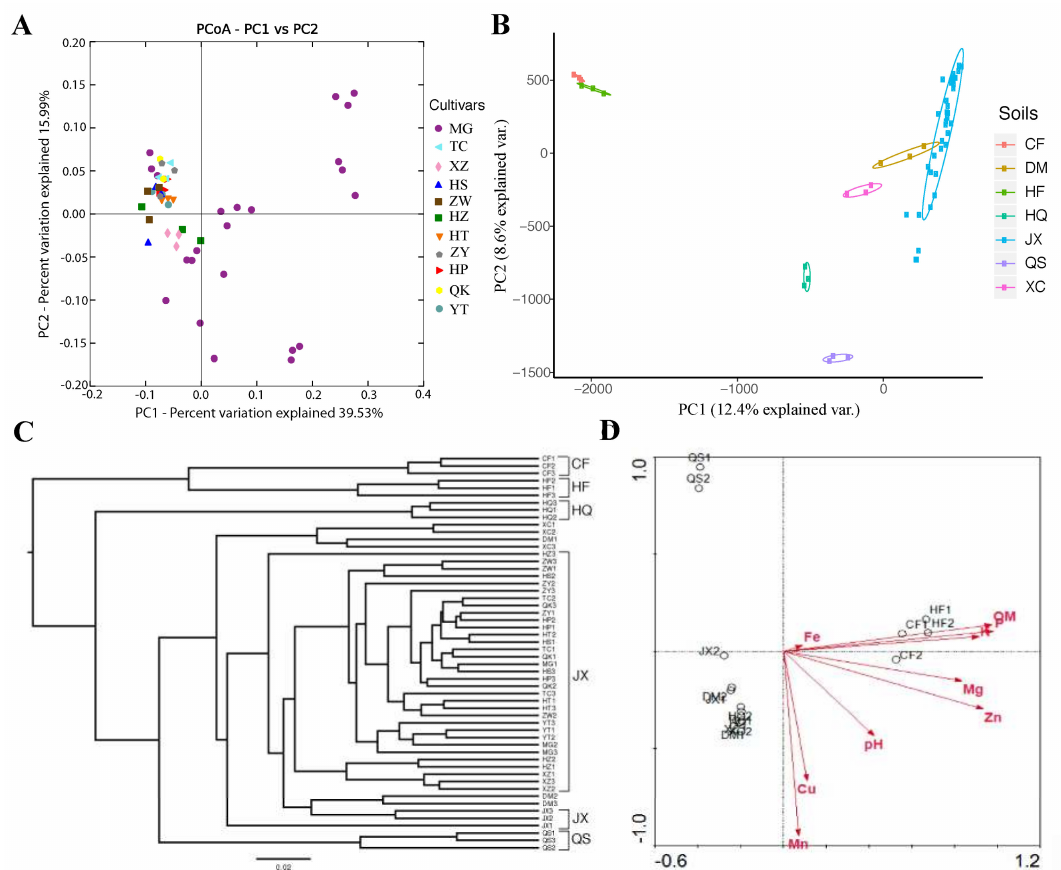
Figure 2. Beta diversity analysis to estimate the dissimilarity and similarity of bacterial community compositions among the cultivars and soil samples. ( A ) Principal coordinate analysis (PCoA) derived from the dissimilarity matrix of weighted UniFrac distances based on the combined data of the cultivars andsoilsamples. ( B )Principalcomponentanalysis(PCA)showingsamplegroupingbasedonsoilsource from the combined data of the cultivars and soil samples. ( C ) Weighted UniFrac-based hierarchical cluster analysis of bacterial community composition based on the combined data of the cultivars and soil samples. ( D ) Canonical correspondence analysis (CCA) showing the main soil biochemical factors that a ff ected the assembly and composition of the rhizobacterial communities based on the combined data of the cultivars and soil samples. Tomato cultivar experiment: Xinzhongshu No. 4 (XZ), Huangshoutao (HT), Tiancheng (TC), Meiguodahong 168 (MG), Huapiqiu (HP), Huangshengnvguo (HS), Huangzhenzhu (HZ), Qiaokeli (QK), Yingtao (YT), Ziwucai (ZW) and Ziyixiannv (ZY); soil experiment: commodity organic nutritional soil (CF), potted plant nutrient soil (HF), vegetable field soil (DM), agricultural field soil (HQ), campus lawn soil (JX), forest soil (QS) and garden soil